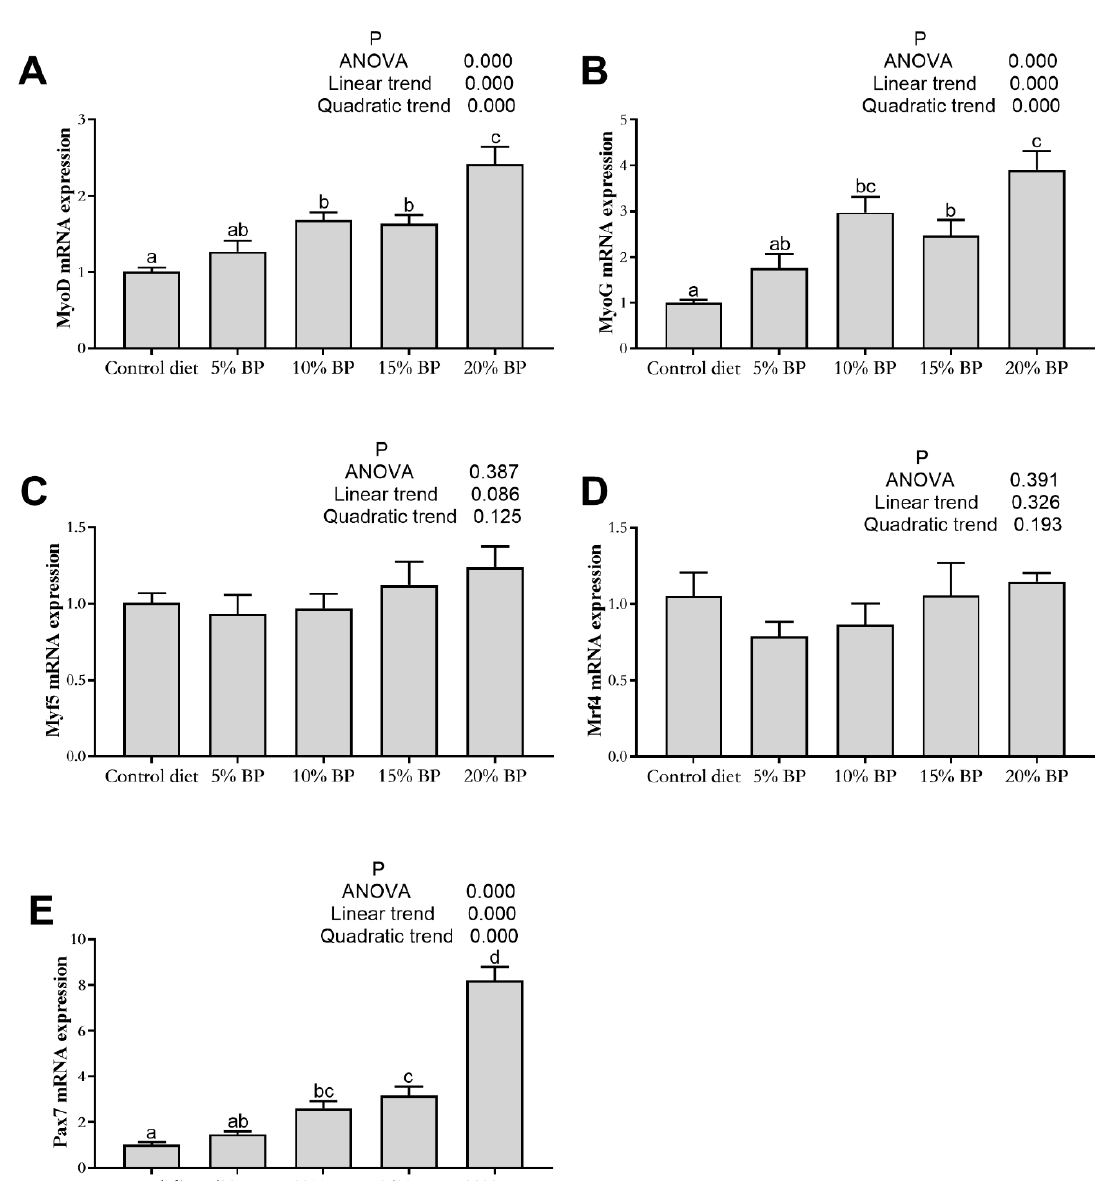
Figure 3. The gene expression of myogenic regulatory factors in the muscle of grass carp fed a diet with paper mulberry (BP) for 8 weeks. MyoD = myoblast determination protein ( A ), MyoG = myogenin ( B ), Myf5 = myogenic factor 5 ( C ), Mrf4 = myogenic regulatory factor 4 ( D ), Pax7 = paired box protein 7 ( E ). Different letters indicate significant ( a, b, c, d ) differences ( p < 0.05, n = 3).